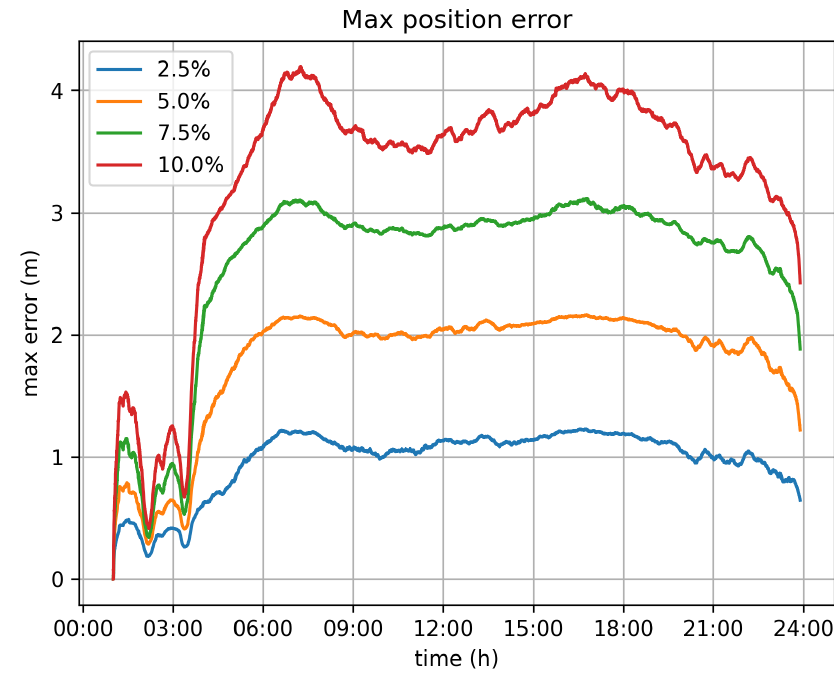
Figure 11. Maximum position